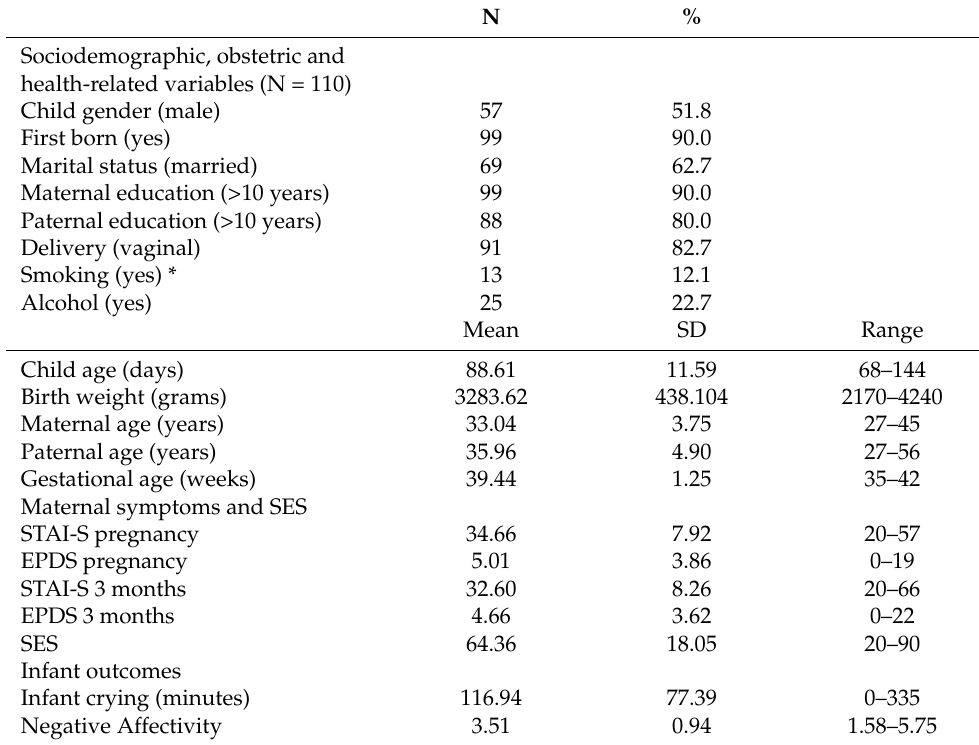
Table 1. Sociodemographic, obstetric, and health-related and study